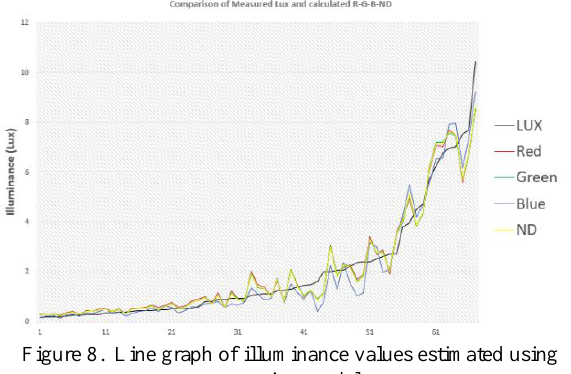
Figure 8. Line graph of illuminance values estimated using regression models.